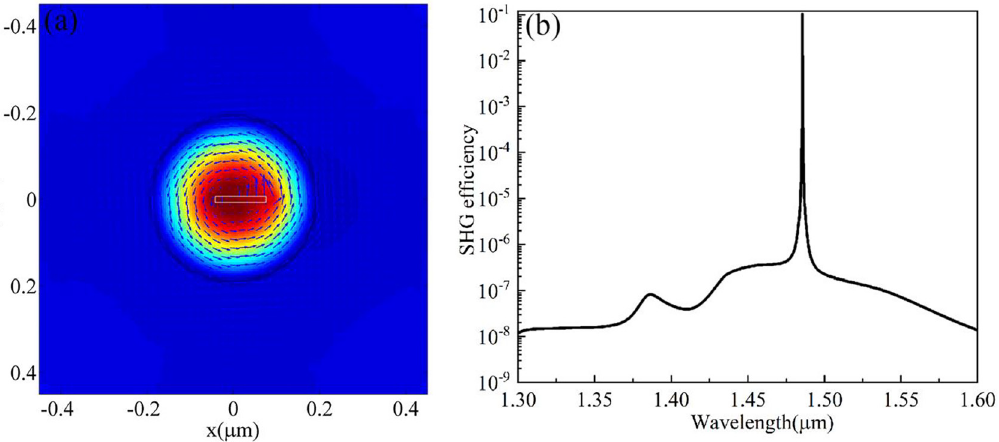
Figure 4: (a) Distribution of the magnetic field amplitude. Superimposed (blue arrows) is the vectorial orientation of the electric field inside the slotted disk at the wavelength of 1.4855 μ m; (b) Calculated second-harmonic generations (SHGs) ef fi ciency in the slotted AlGaAs disk